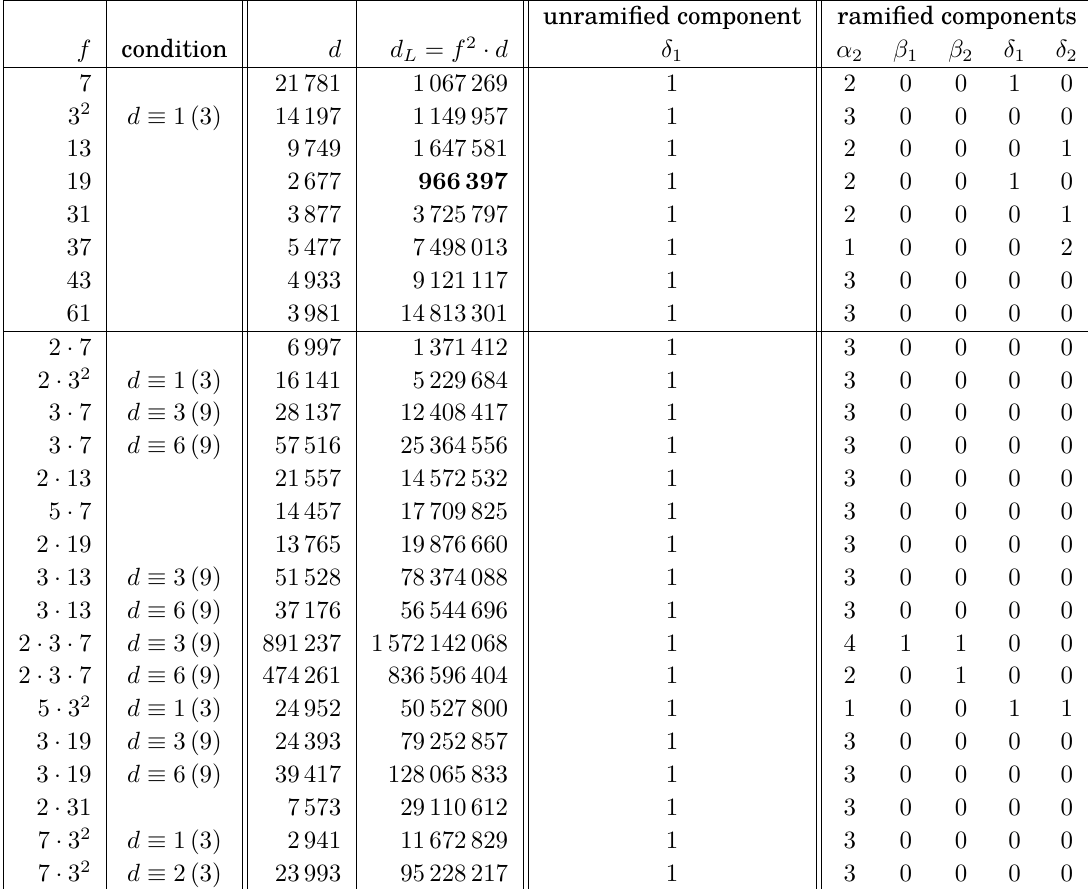
Table 30: Heterogeneous quartets of S 3 -fields with conductor f , where s = 1 . unramified component ramified